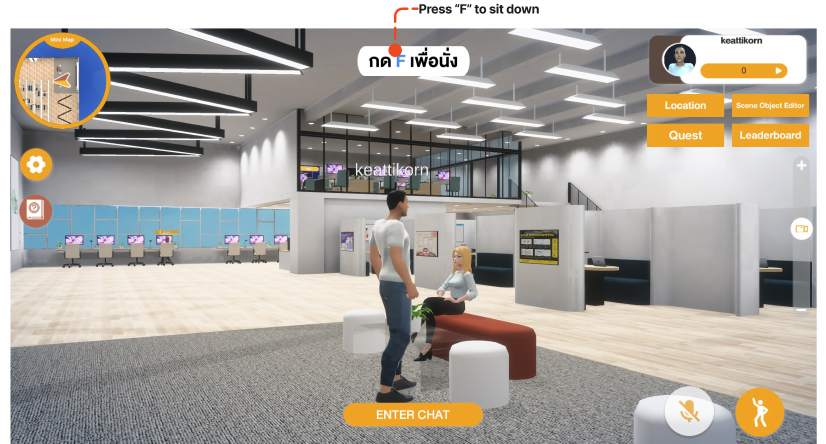
Figure 7. Software engineering department (SE) interior that matches the theme of the curriculum. The user can sit down on the couch by following the suggestion displayed on the user interface on the top centre as “Press F to sit down”.